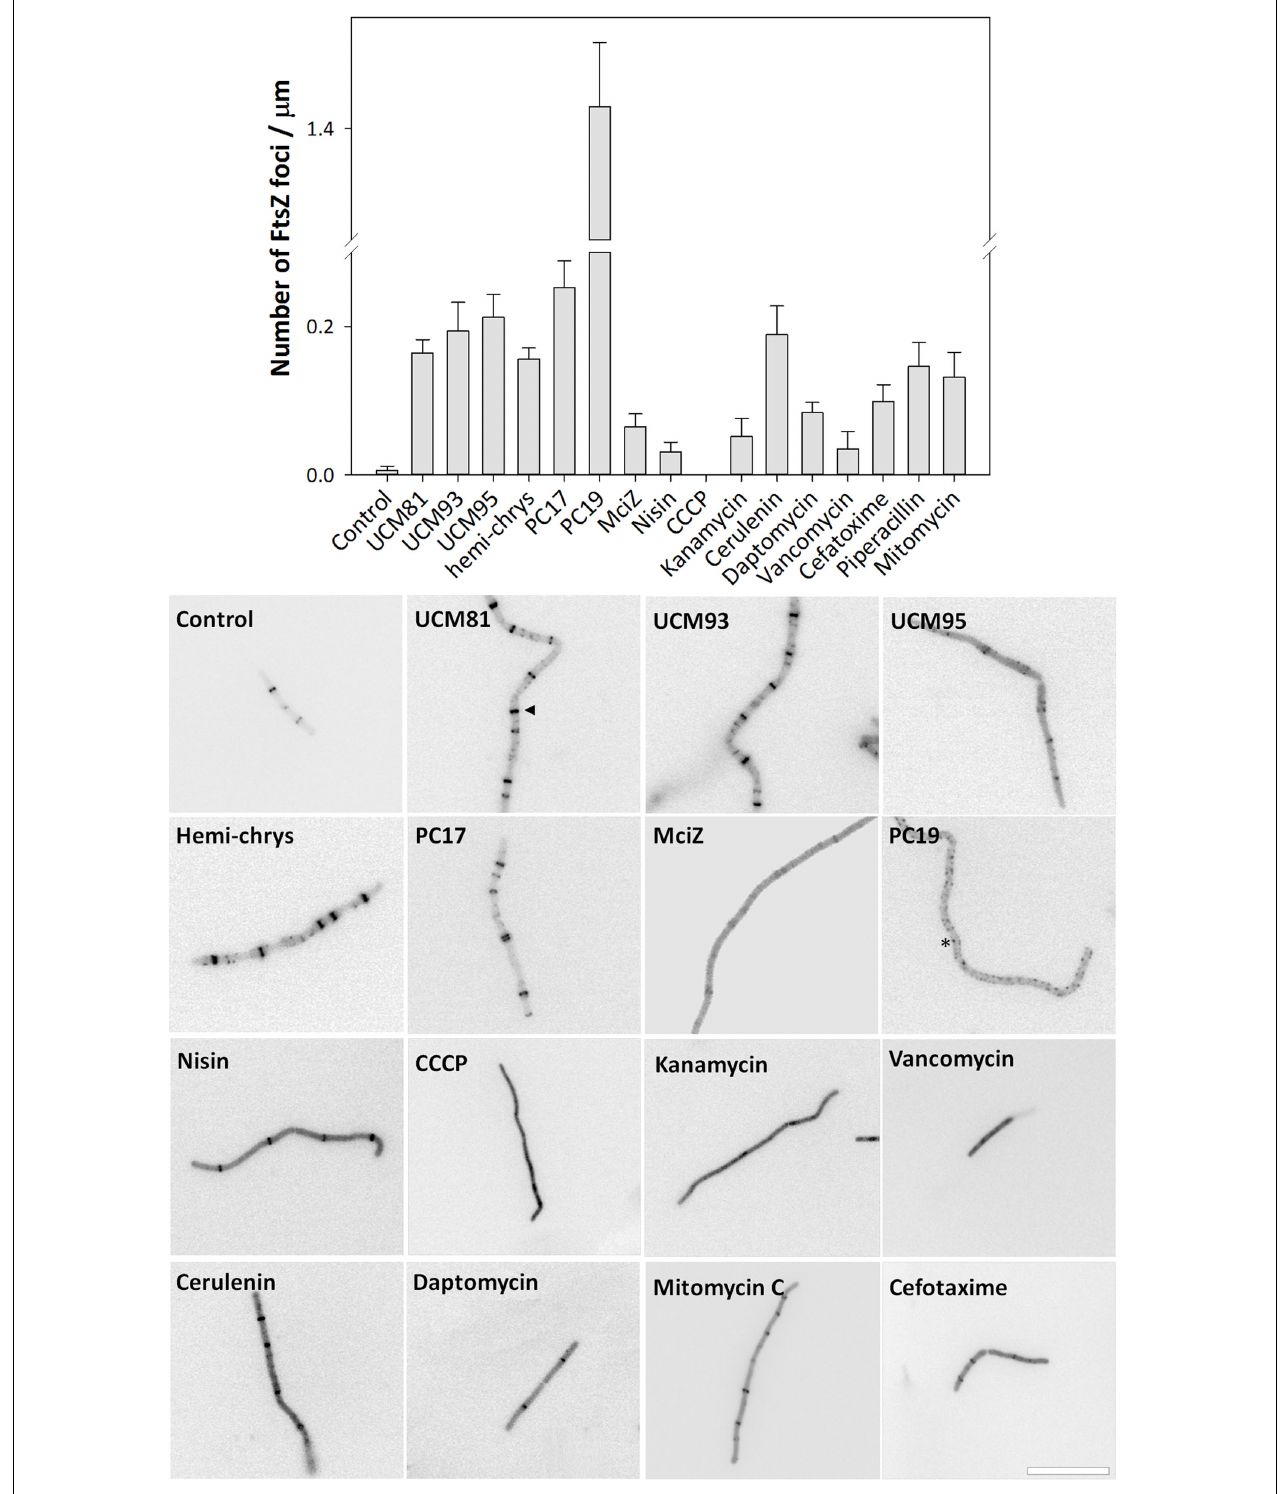
FIGURE 4 | Effects of FtsZ inhibitors on FtsZ subcellular localization. Cells of B. subtilis SU570 (FtsZ-GFP) were incubated for 1.5 h with the different compounds and visualized under the fluorescence microscope. Z-rings and FtsZ foci were observed (see Materials and Methods, the triangle and the asterisk indicate examples of ring and foci , respectively). The number of foci per micron were quantified (graphic; average and standard error are shown, n = 3). Scale bar: 10 µ m.